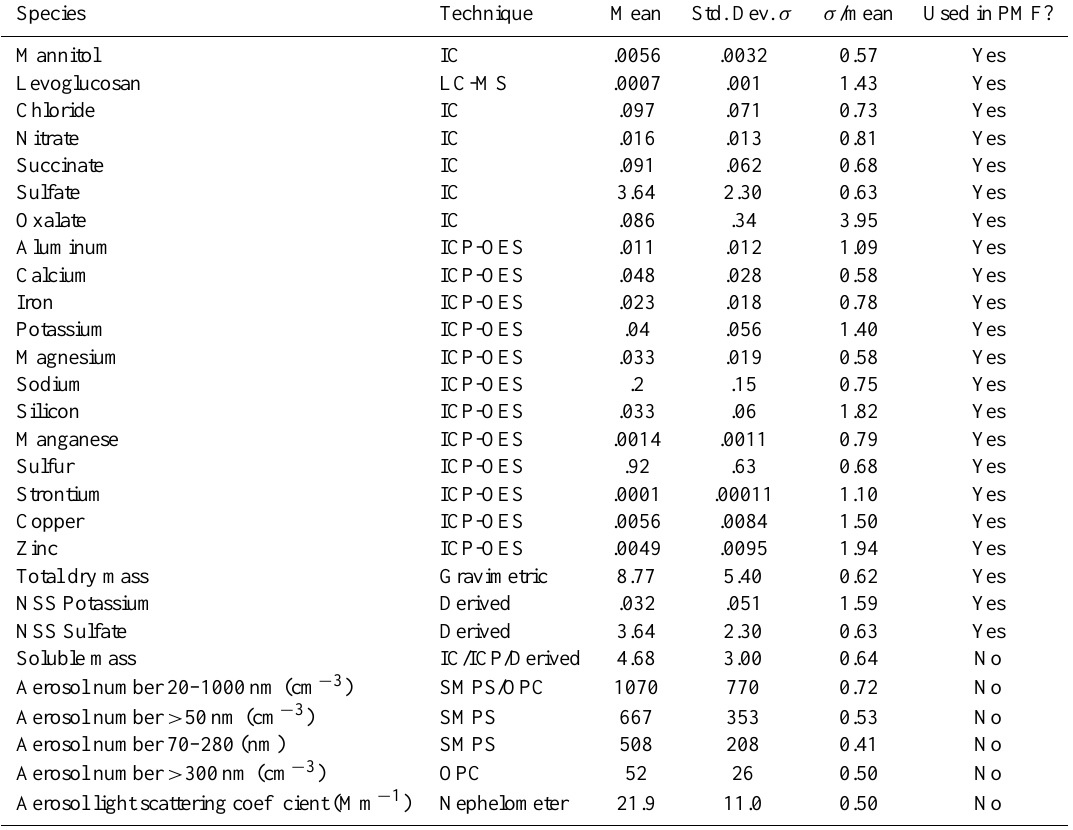
Table 2. Summary of the mean values and standard deviations of the aerosol species masses and other physical parameters observed during the study. Unless otherwise indicated, the units are in µgm − 3